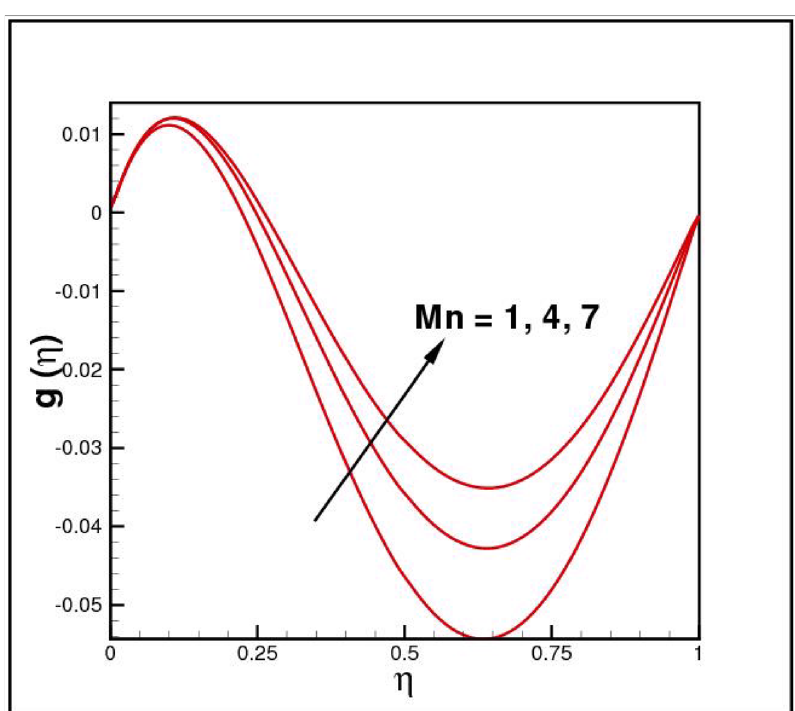
Figure 6. Impact of Mn on g ( η